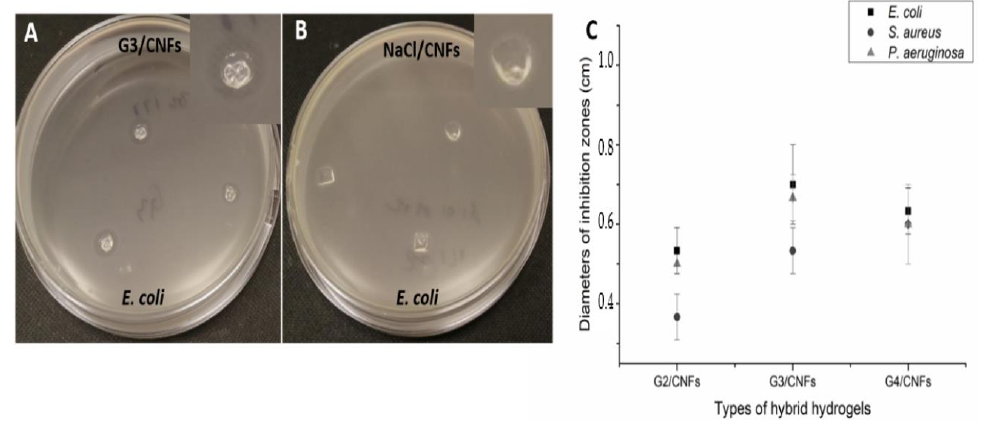
Figure 4. The disk di ff usion test of ( A ) G3 / CNFs towards E. coli , ( B ) NaCl / CNFs towards E. coli , ( C ) average diameters of inhibition zones of the hybrid hydrogels against E. coli , S. aureus and P. aeruginosa.